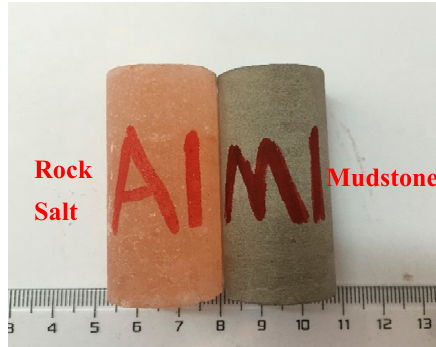
Figure 11. Natuural specimens. Figure 11. Natu